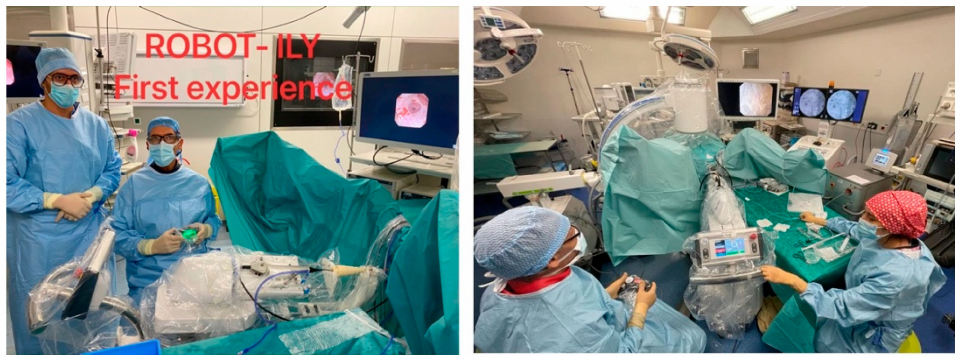
Figure 8. Surgeon handling the remote control for laser